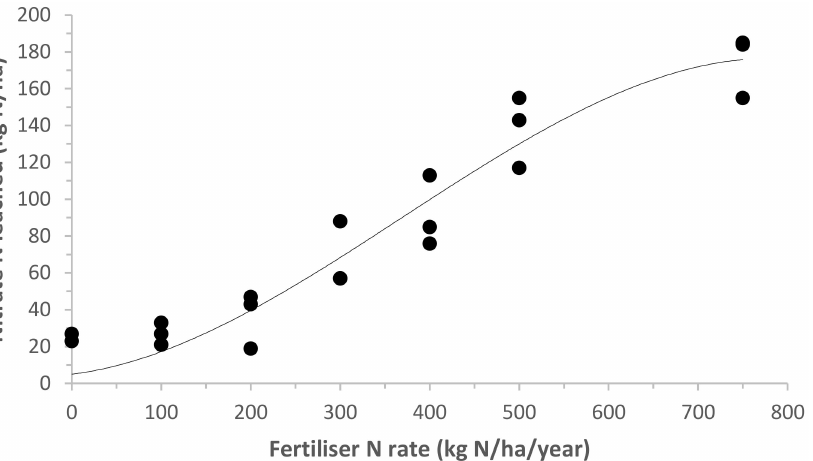
Figure 2. Nitrate leached from sheep-grazed pasture systems under different nitrogen (N) fertiliser rates. Data adapted from Hoogendoorn et al.